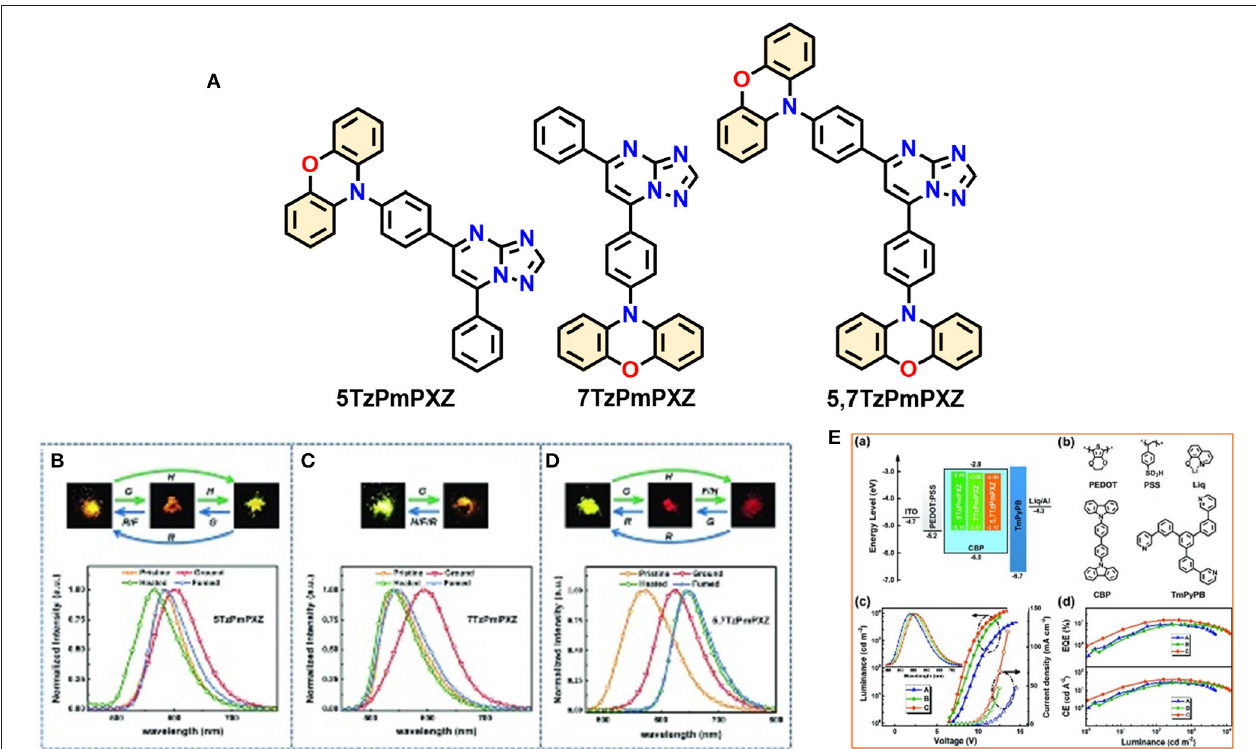
FIGURE 6 | (A) Molecular structures of studied compounds. Photos and PL spectra of (B) 5TzPmPXZ, (C) 7TzPmPXZ, and (D) 5,7TzPmPXZ in response to external stimuli. Under 365nm UV irradiation (G: grinding with a mortar and a pestle; H: heating at 150 ◦ C for 5TzPmPXZ and 7TzPmPXZ, 200 ◦ C for 5,7TzPmPXZ; F: fuming with CH 2 Cl 2 vapor; R: recrystallization from n-hexane/CHCl 3 ). (E) OLED performances: (a) the energy level diagrams for the devices A, B, and C, (b) chemical structures of HTL-PEDOT:PSS, CIL-Liq, Host-CBP, and ETL-TmPyPB. (c) J-V-L curves for devices A, B, and C (inset: the normalized EL spectra of devices). (d) EQE and LE vs. luminance curves for devices A, B, and C. Reproduced with permission from Zeng et al. (2018). Copyright © WILEY-VCH Verlag GmbH andamp; Co. KGaA, Weinheim.